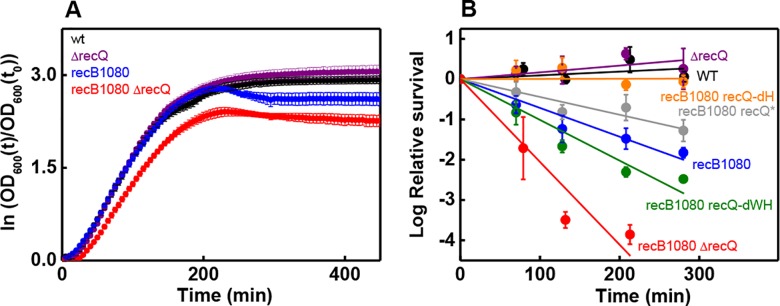
Loss of RecQ function compromises the survival of recB1080 cells under replication stress.(A) Time-dependent OD600 profiles (ln (OD600(t)/OD600(t0)), means ± SE) of indicated E. coli strains in the presence of 100 mM HU. (B) Time-dependent HU (100 mM) survival profiles of indicated E. coli strains, monitored via changes in CFU/ml (means ± SE). Solid lines show linear regression best-fits to the time dependence of log-transformed relative survival data. Results of statistical comparison of best-fit slopes are shown in S4 Table.